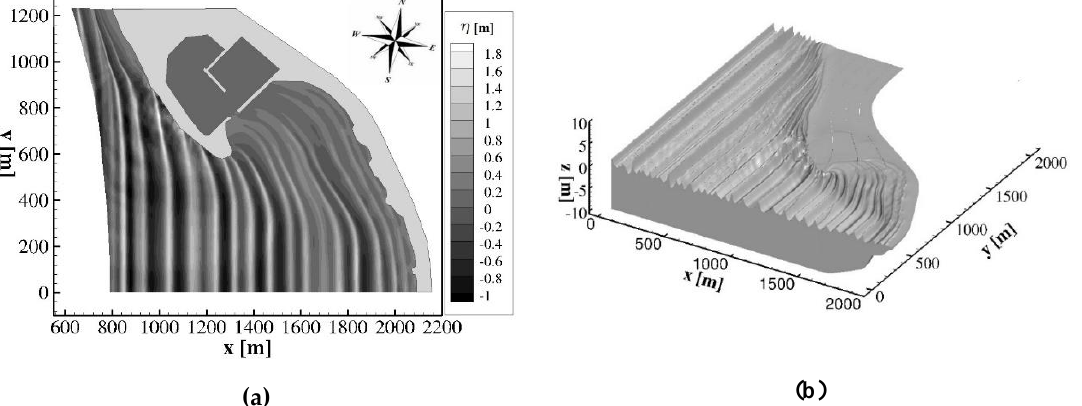
Figure 8. (a) Plan view and (b) three-dimensional view of an instantaneous wave field obtained by the numerical simulation of the significant wave event in the coastal region of Cetraro harbour in the present configuration. 𝜂 : free surface elevation.